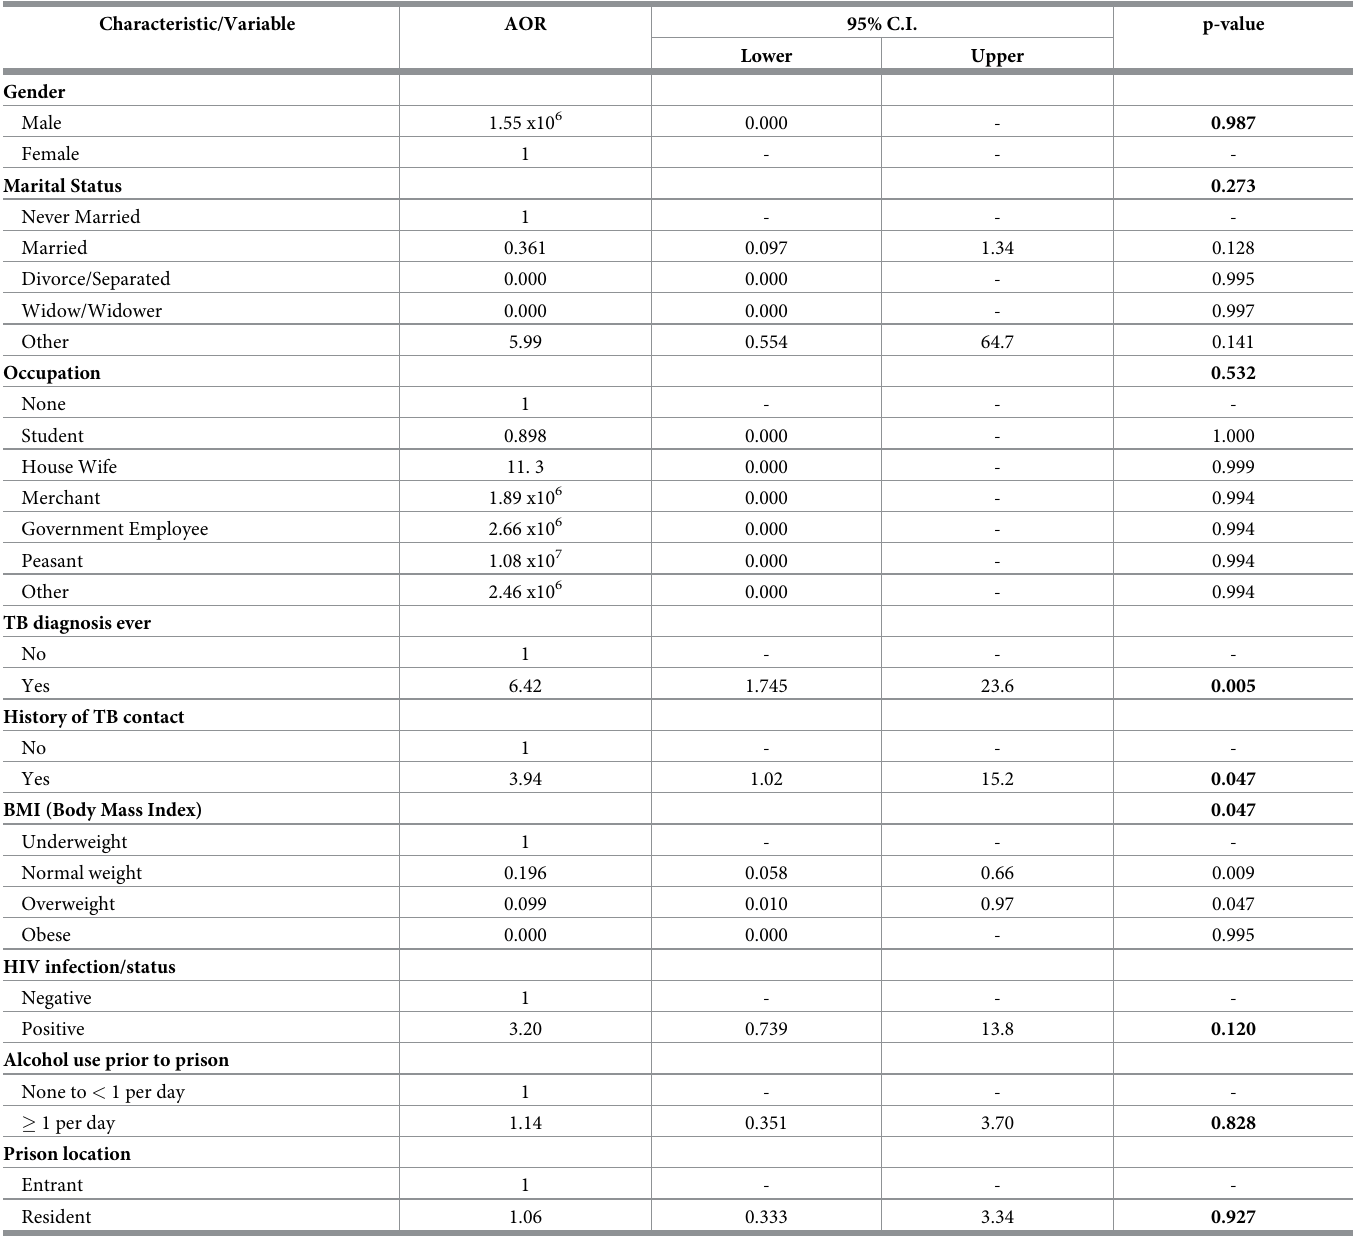
Table 6. Multi-variate analysis of BC-PTB infection and its related risk factors.